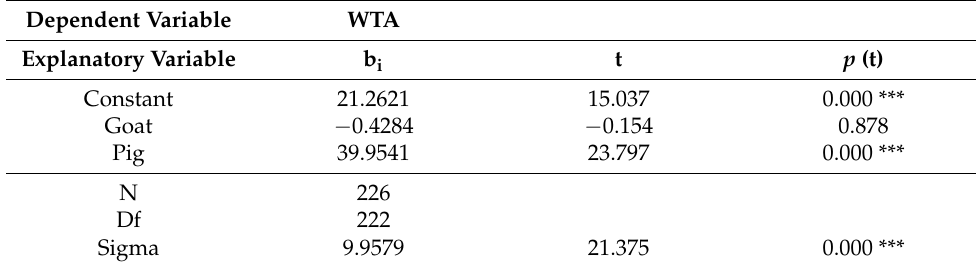
Table 5. WTA interval regression estimation